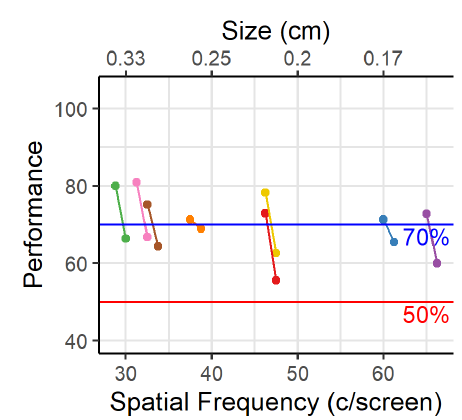
Figure 4. Visual acuity. Interpolation between the two SFs for which the performance was just above and below 70%. SF is shown per animal as c/screen (bottom axis) and as the width of one cycle (top axis).